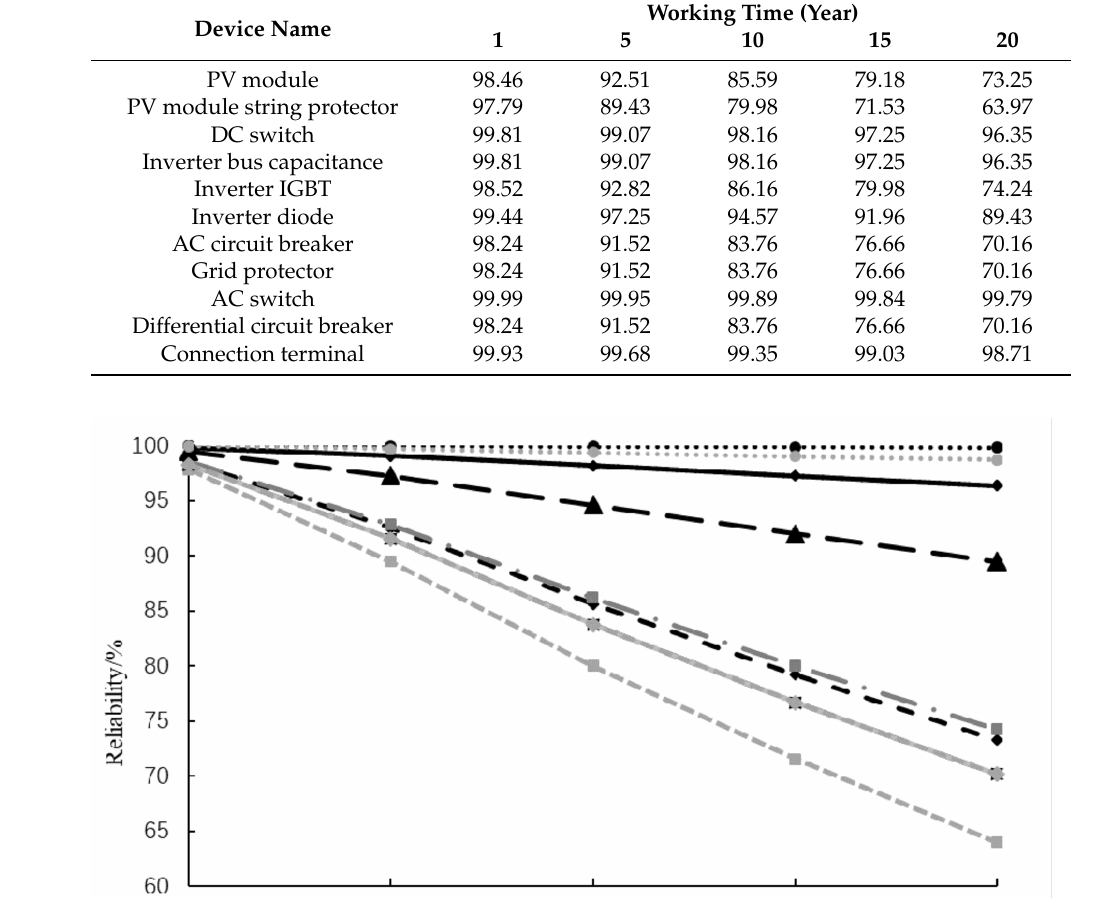
Table 4. Reliability of each component within 20 years of 100 KW grid-connected PV power station.